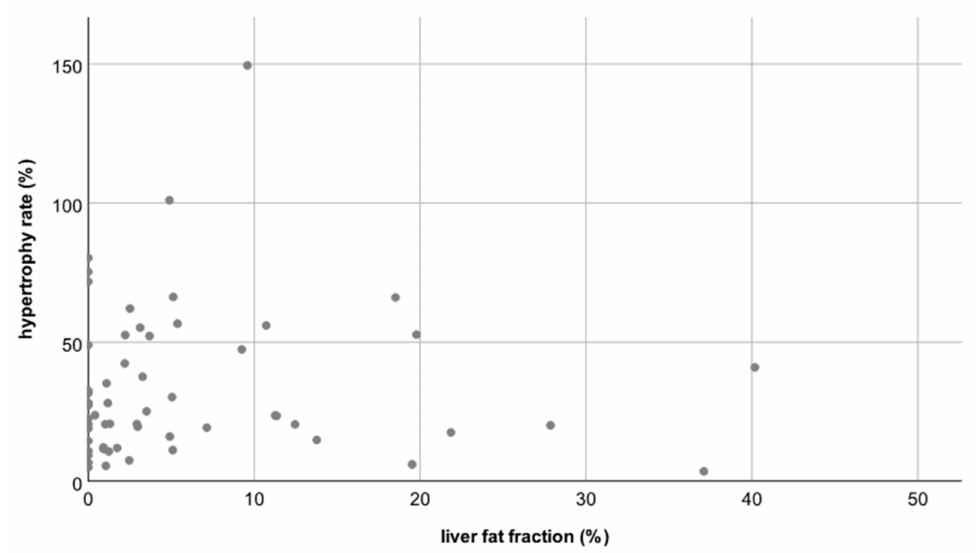
Figure 3. Scatterplot A: No correlation between the liver fat fraction (hFF) and the hypertrophy rate (HR); correlation coefficient R = − 0.04.